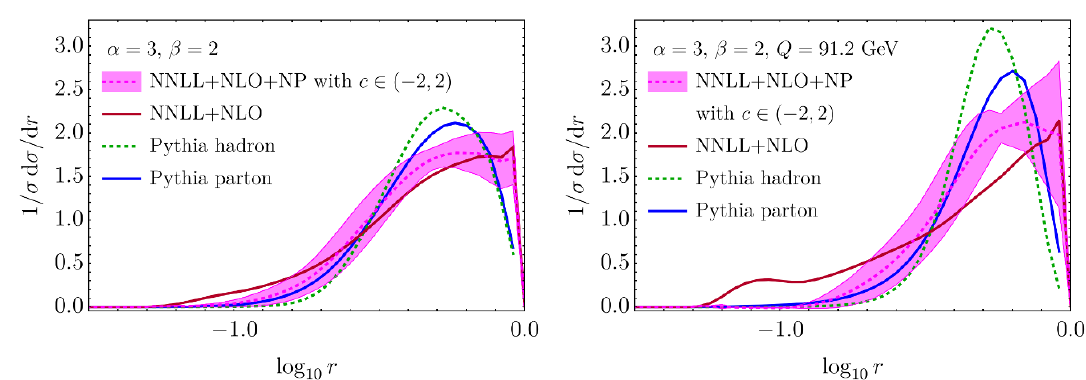
Figure 13 . Distribution for the ratio of two angularities from the NNLL+NLO cross section with and without nonperturbative e(cid:11)ects, for ( (cid:11); (cid:12) ) = (3 ; 2), compared to Pythia at parton and hadron level for Q = 1000 GeV (left) and Q = 91 : 2 GeV (right). The band indicates the uncertainty from nonperturbative e(cid:11)ects, as described in the